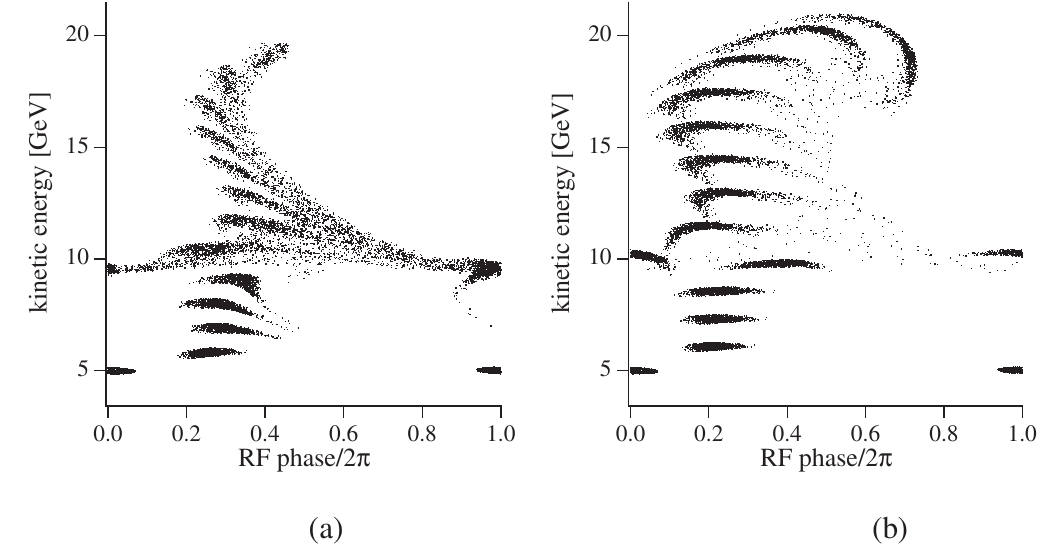
FIG. 8. Longitudinal emittance evolution of a two FFAG cascade with 100% transverse emittance of 30 (cid:1) mm rad . (a) Nominal rf voltage and no higher harmonic rf. (b) Second harmonic rf added and 10% increase of rf voltage.